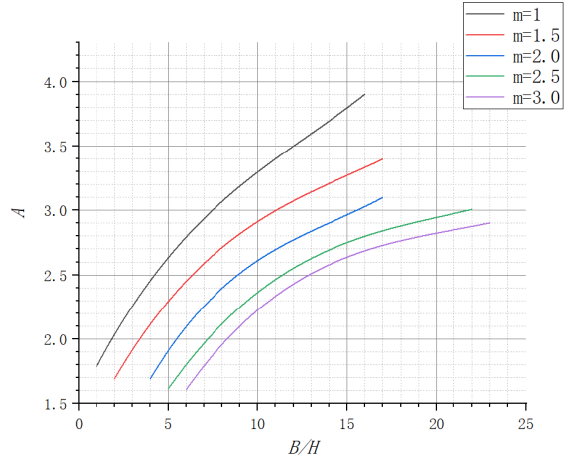
Figure 3. Relation curve.